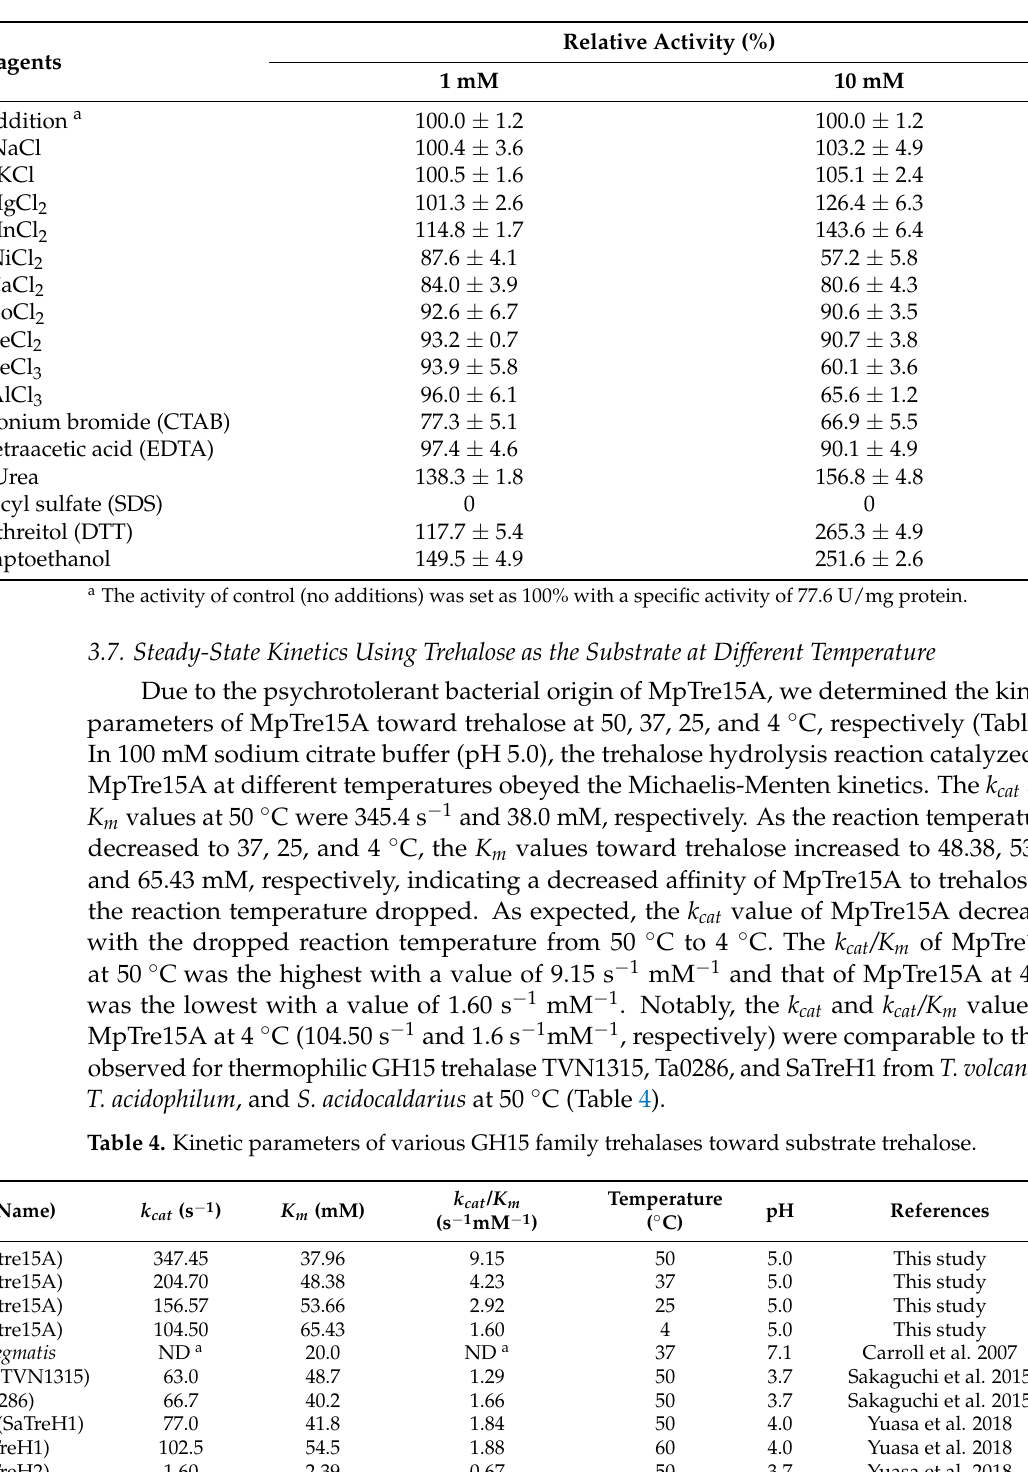
Table 3. Effects of various chemicals on the relative activity of MpTre15A.